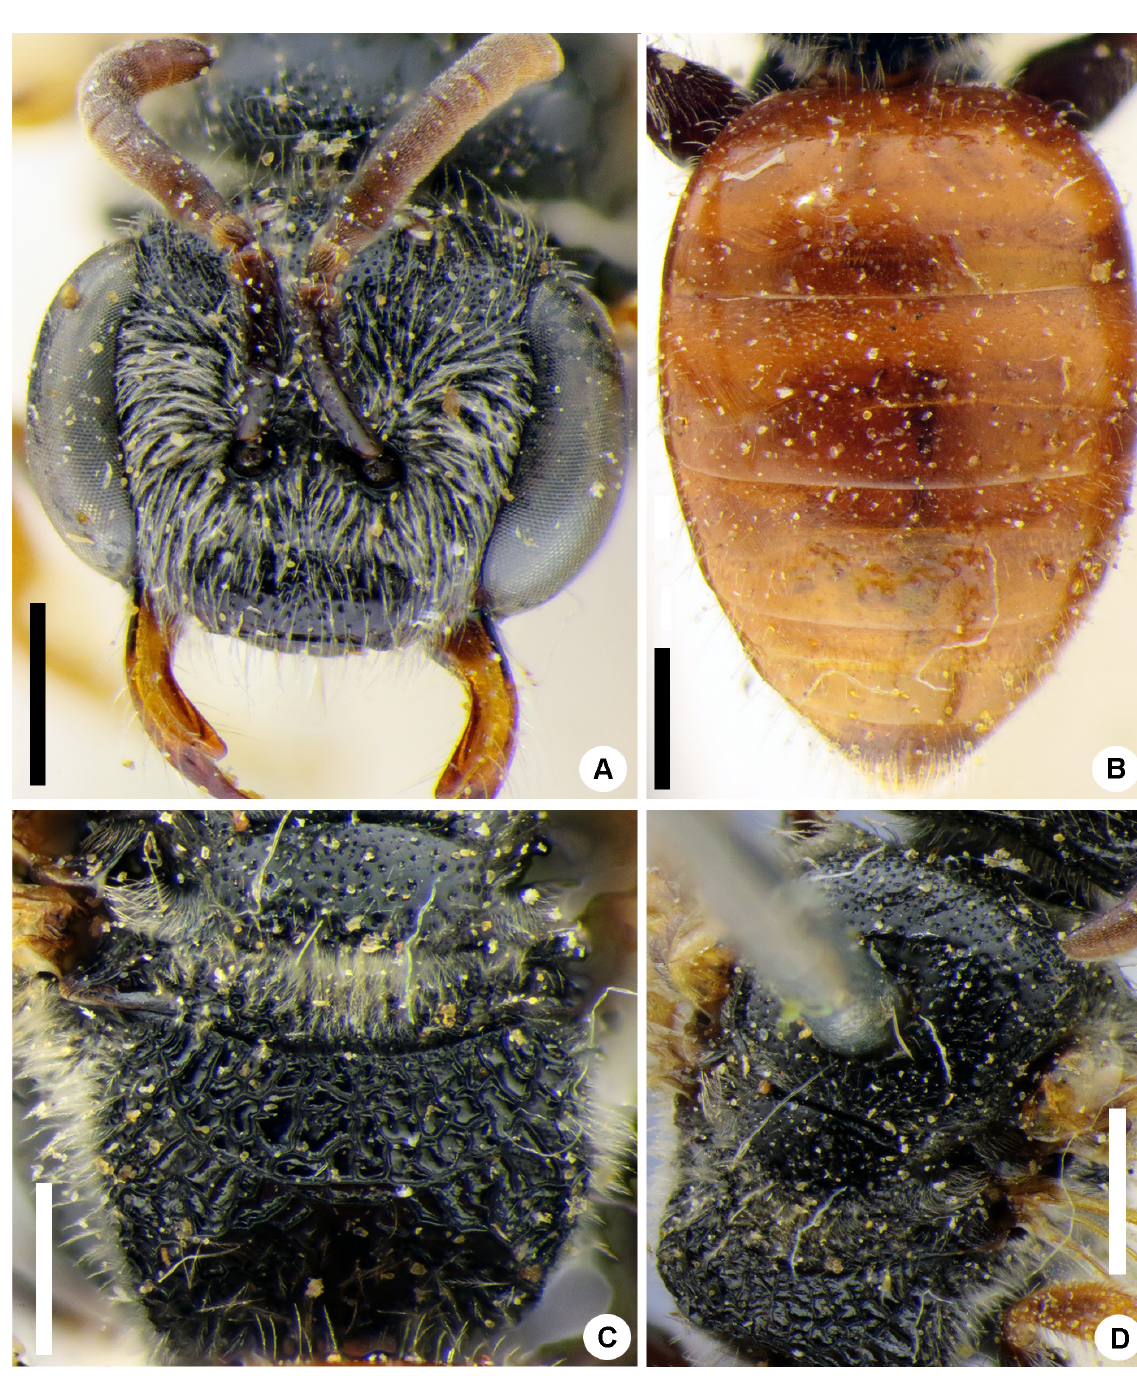
Fig. 15. Sphecodes perplexus Nurse, 1903. Syntype, ♀ (ZMHB). A . Head in frontal view. B . Metasoma in dorsal view. C . Mesoscutum and propodeum in dorsal view. D . Mesosoma in dorsal view. Scale bars = 0.5